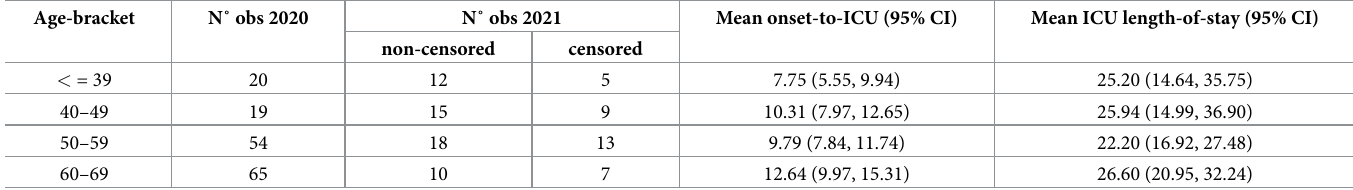
Table 1. Summary of data on onset-to-ICU interval and ICU length-of-stay